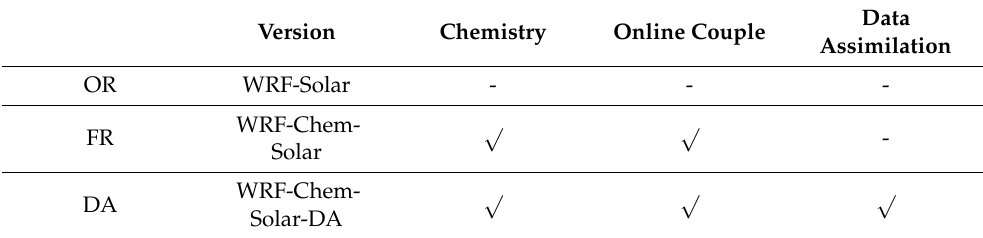
Table 2. Experimental design for the sensitivity tests in this